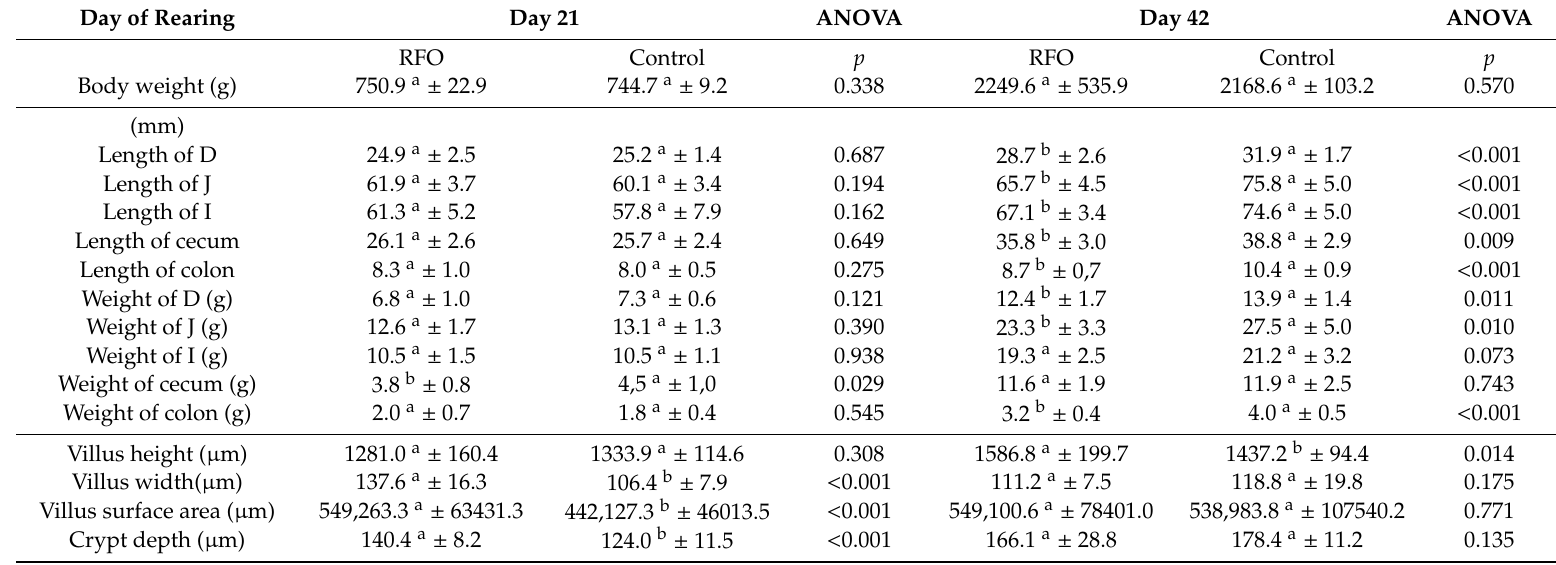
Table 3. E ff ect of the in ovo RFO prebiotic treatment on intestinal structure and duodenum histomorphology of 21- and 42-day-old broiler